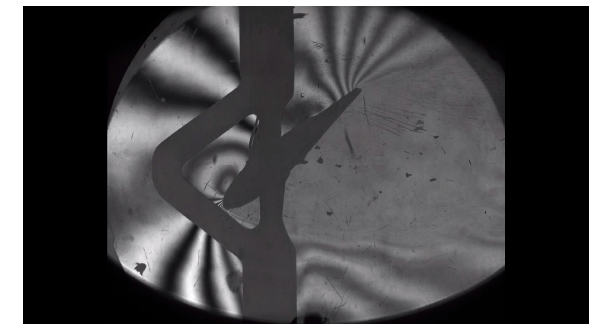
Fig. 13c. Interferogram, airfoil at maximal negative inclination.